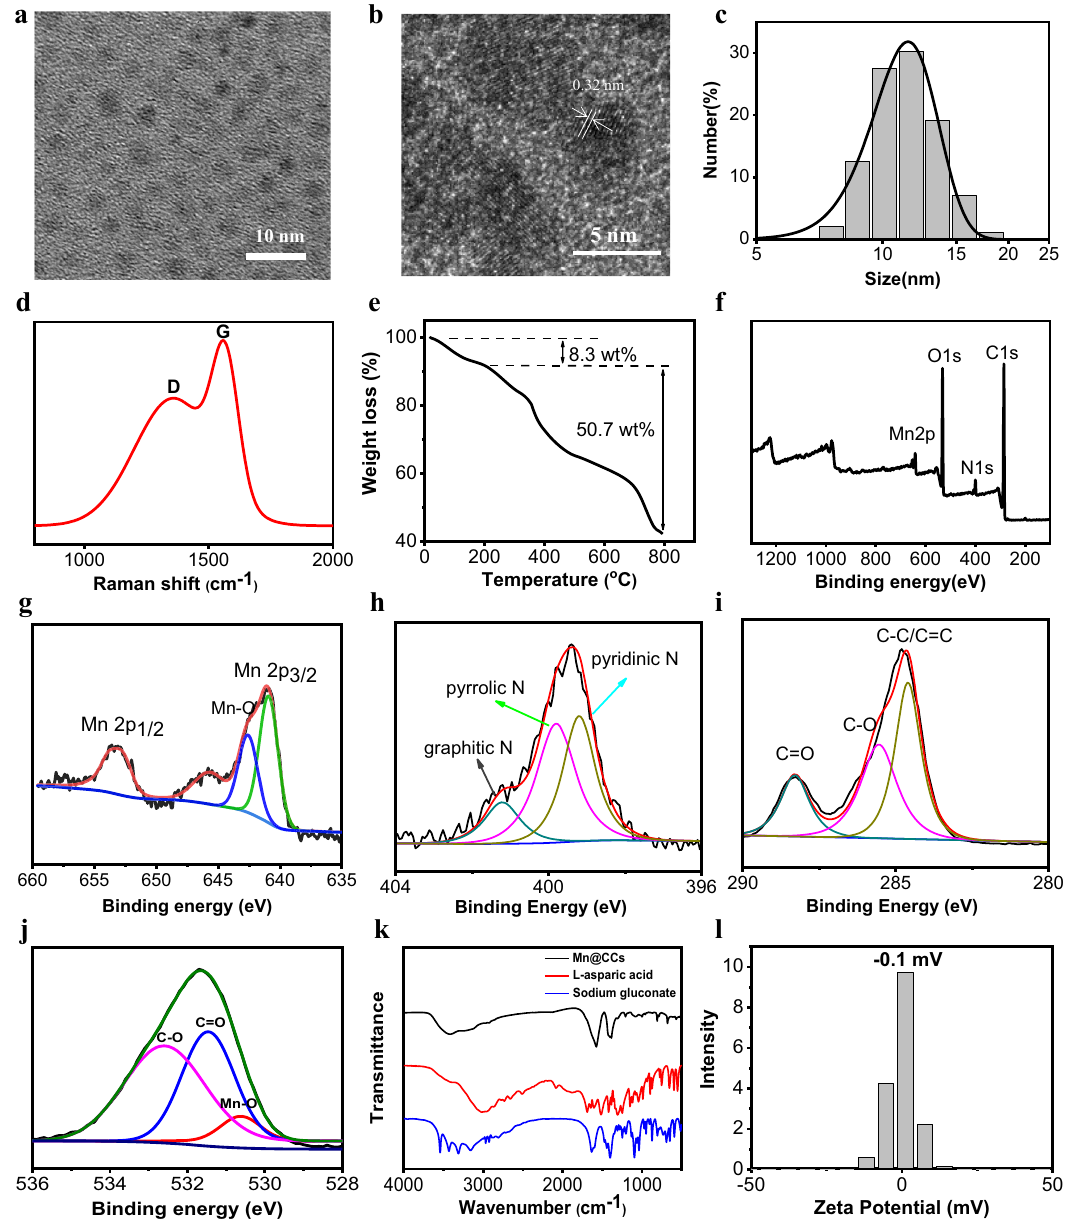
Fig. 1 Characterizations of Mn@CCs. a TEM image of Mn@CCs. b The graphene-like structure of Mn@CCs revealed by HR-TEM imaging. Experiments were repeated three times. c Size distribution of Mn@CCs. d Raman spectrum of Mn@CCs. e TGA of Mn@CCs. f The full-scan XPS spectrum of Mn@CCs. g – j High-resolution XPS spectra of g Mn2p, h N1s, i C1s, and j O1s. k FTIR spectra of Mn@CCs and raw materials. l Surface zeta potential of